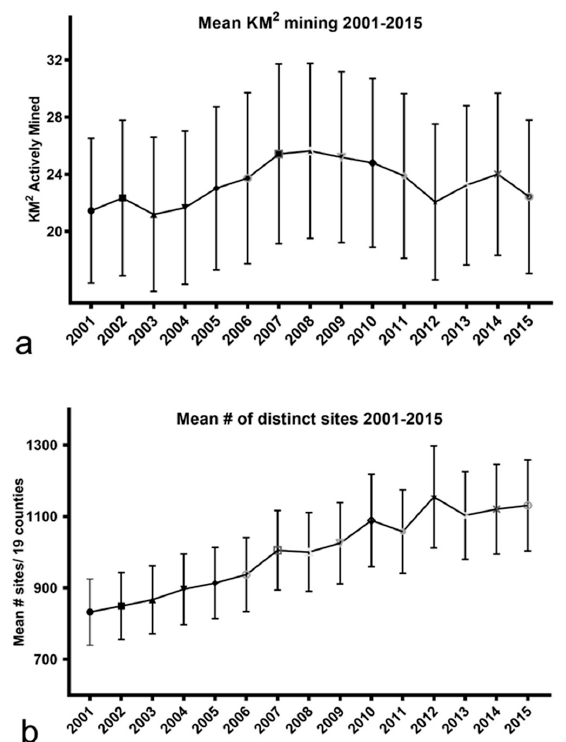
Figure 12. Mean km 2 mined vs. mean distinct sites mined per year from 2001–2015. ( a ) Km 2 mined remained relatively flat over the 15 year period whereas ( b ) the number of distinct sites rose steadily. Error bars = S.E.M.s.